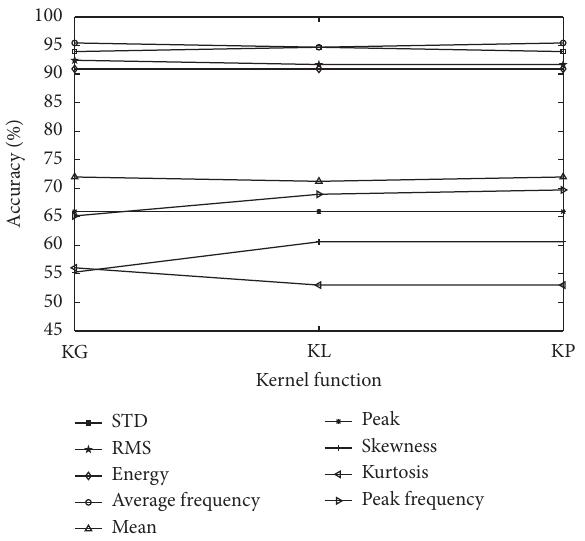
Figure 4: The results after running the test for 9